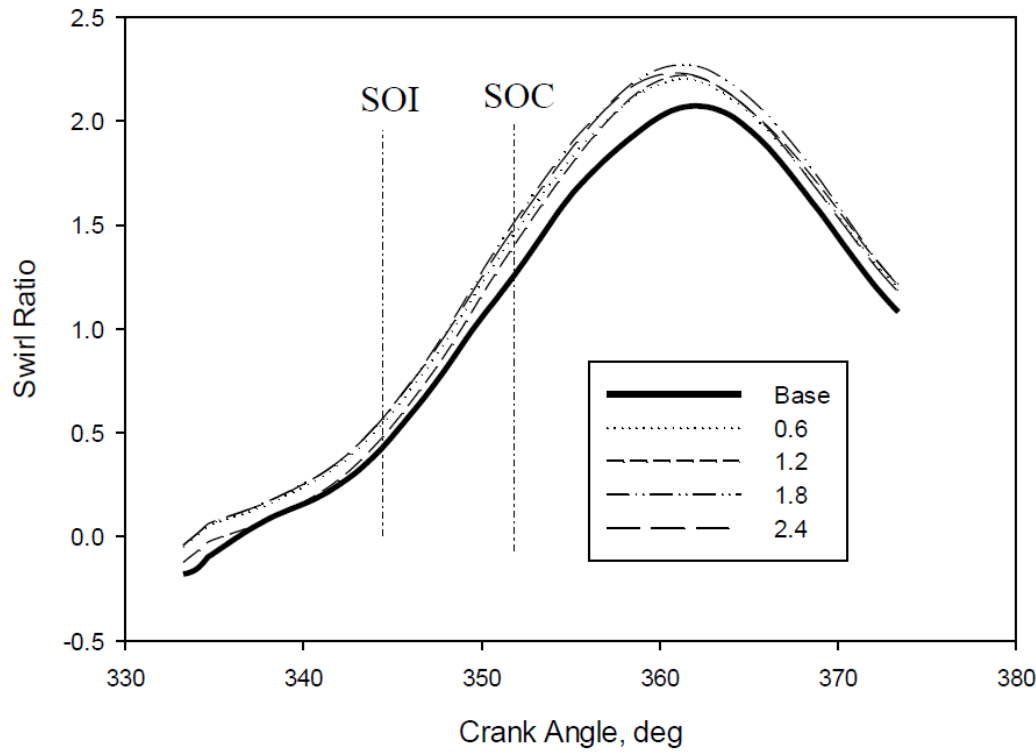
Figure 9. The plot of the swirl strength against the crank angle.